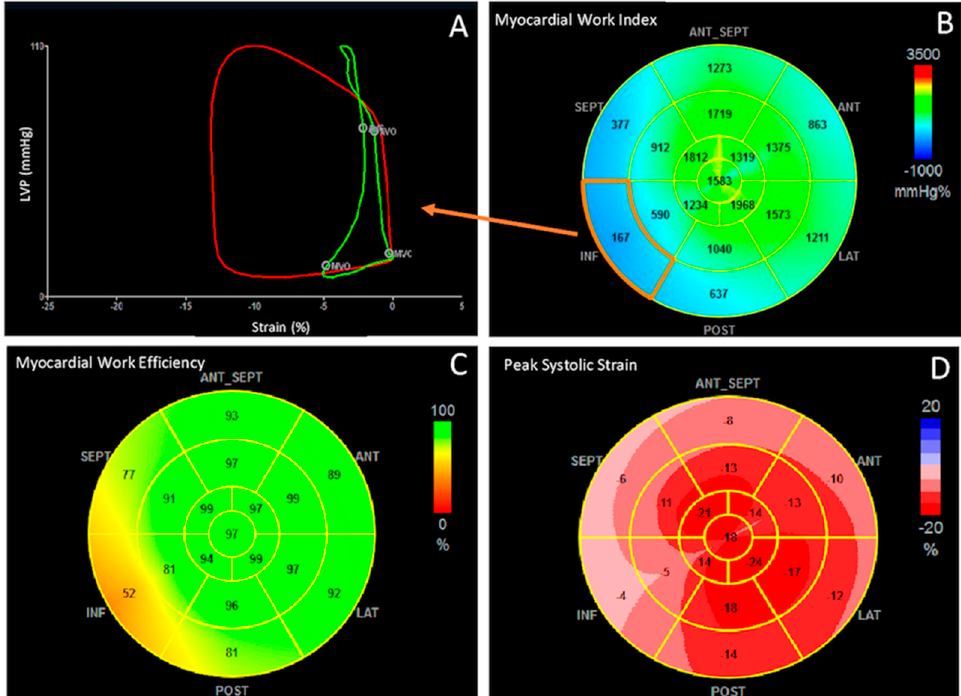
Figure 2. Myocardial work indices in a patient with inferior ST-elevation myocardial infarction. Pressure-strain loop of the basal segment of the inferior wall showed post-systolic shortening, early marker of ischemia, which translate into an important decrease of MW index ( A , B ), global work efficiency ( C ) and global longitudinal strain ( D ) in the territories supplied by the obstructed right coronary artery. LVP = left ventricular pressure.